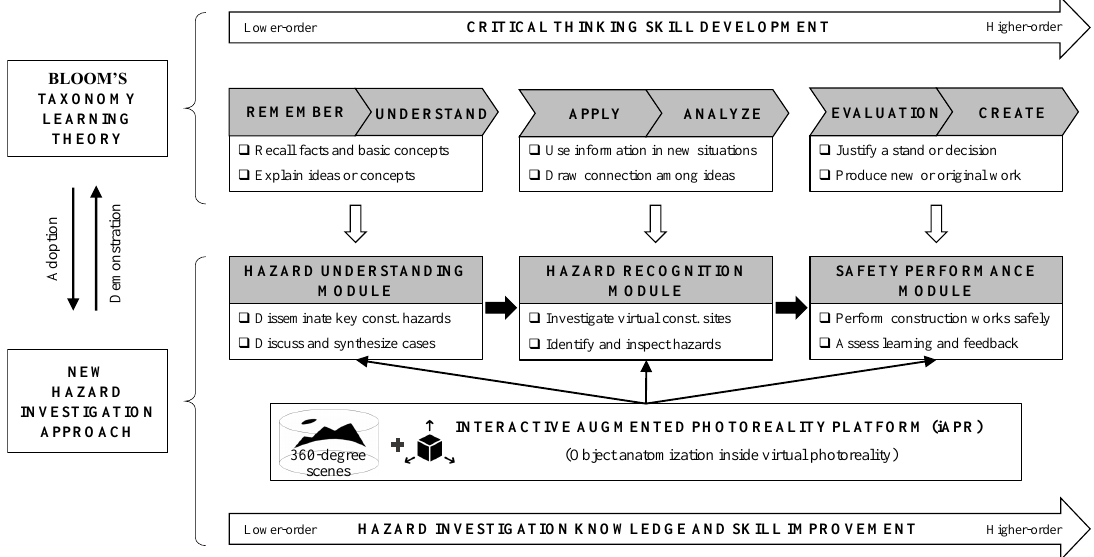
Figure 1. Learning